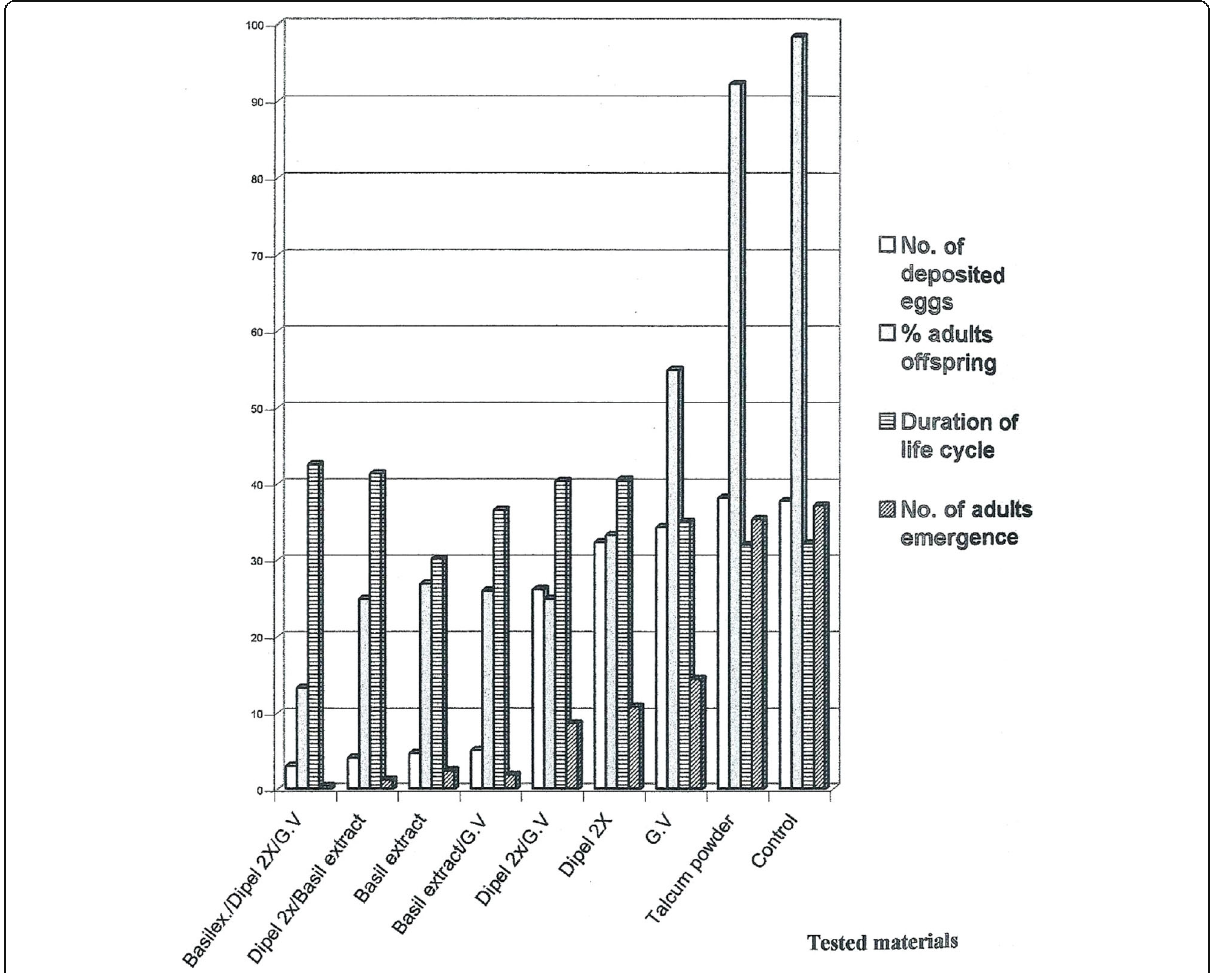
Fig. 1 Damage index in potato tubers treated with different microbial insecticides and basil